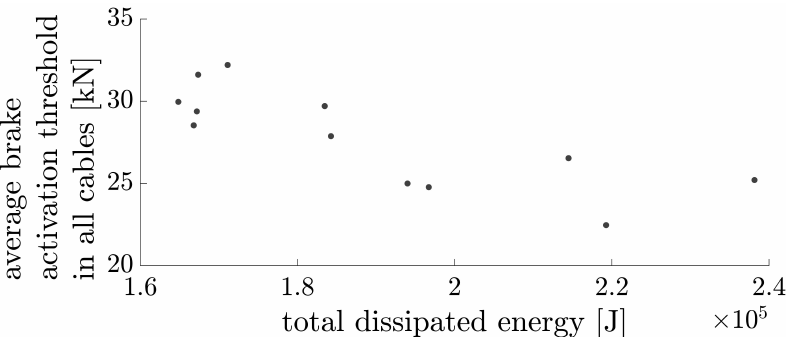
Figure 24. Global energy variation according to the average brake-activation threshold in all cables.